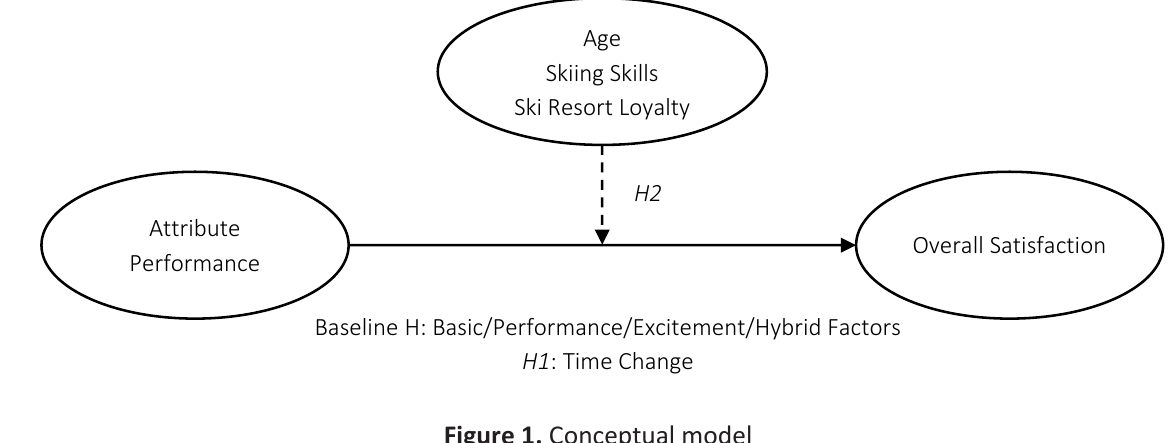
Figure 1. Conceptual